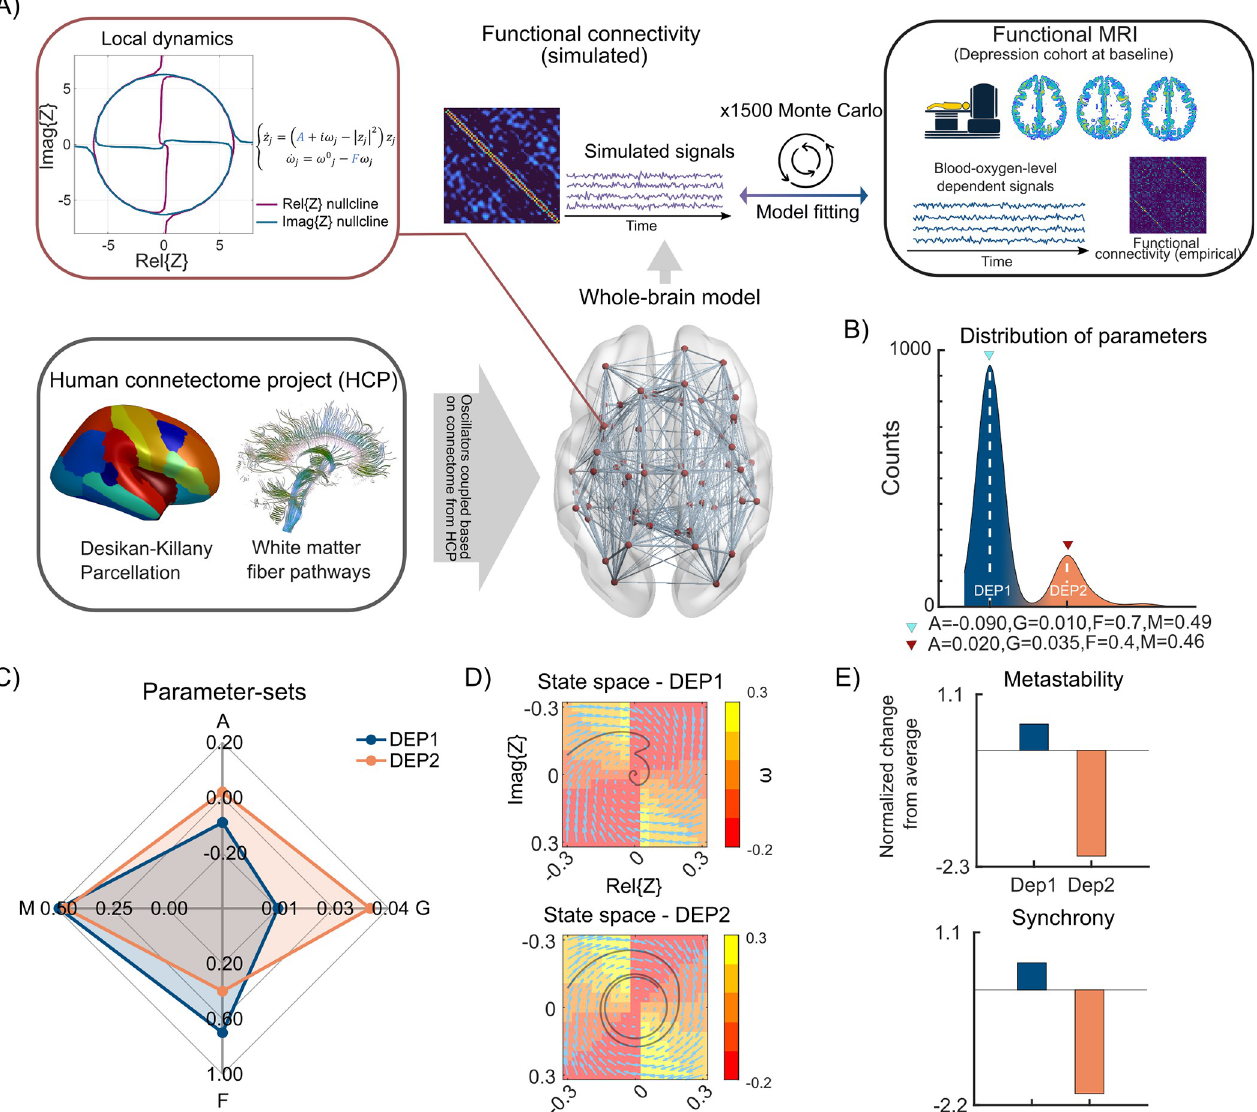
Fig 1. Whole-brain modeling stratifies the depression sample. (A) The whole-brain model was constructed from oscillators with amplitude and angular frequency dynamics, which were coupled through the structural connectome. The model parameters were optimized in an iterative Monte Carlo procedure based on the similarity between model-derived functional connectivity with that of the empirical data. The white matter fiber tracks figure was adopted from Wikipedia.com (https://en.wikipedia.org/wiki/Diffusion_MRI#Diffusion_tensor_imaging) under a CC BY 4.0 license. (B) The distribution of parameter-sets obtained from 1500 Monte Carlo resamplings across three thresholds (i.e., 30%, 50% and 70%) indicated two peaks, representing two subtypes in the data, so- called DEP1 and DEP2. The graphs depict (C) different optimal parameter-sets capturing differences in amplitude and angular frequency dynamics in the depression cohort and (D) their respective state spaces. The black spirals represent the underlying stable focus attractors, while the angular frequency state variable ω is color-coded. (E) The bar graphs denote the normalized difference in metastability and synchrony across the two depression subtypes. DEP1 exhibited higher metastability and synchrony, whereas DEP2 demonstrated lower metastability and synchrony compared to the average of the Monte Carlo resampling distribution.